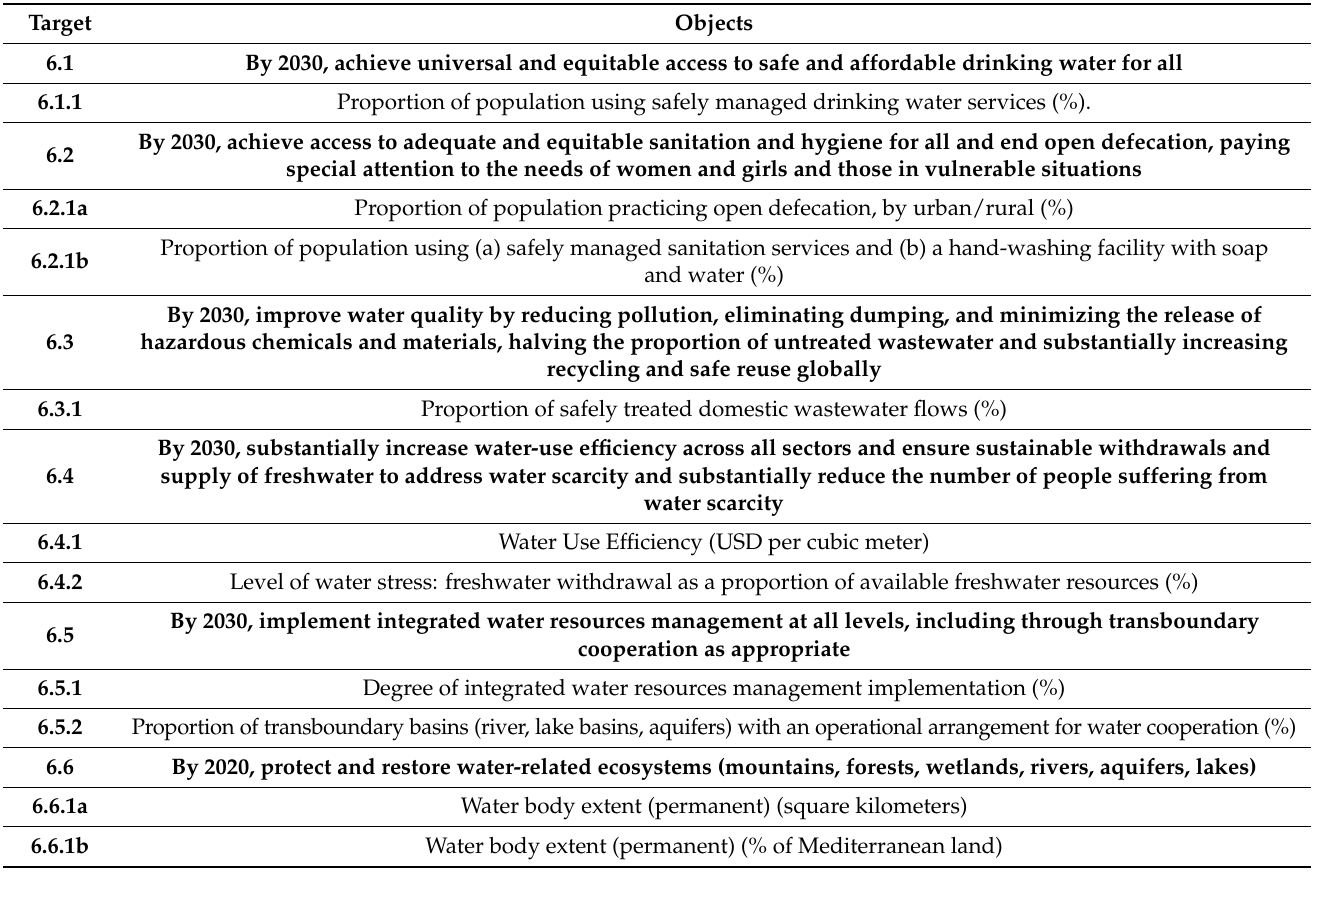
Table 1. Goal 6 and its targets. Main indicators considered for the Mediterranean area